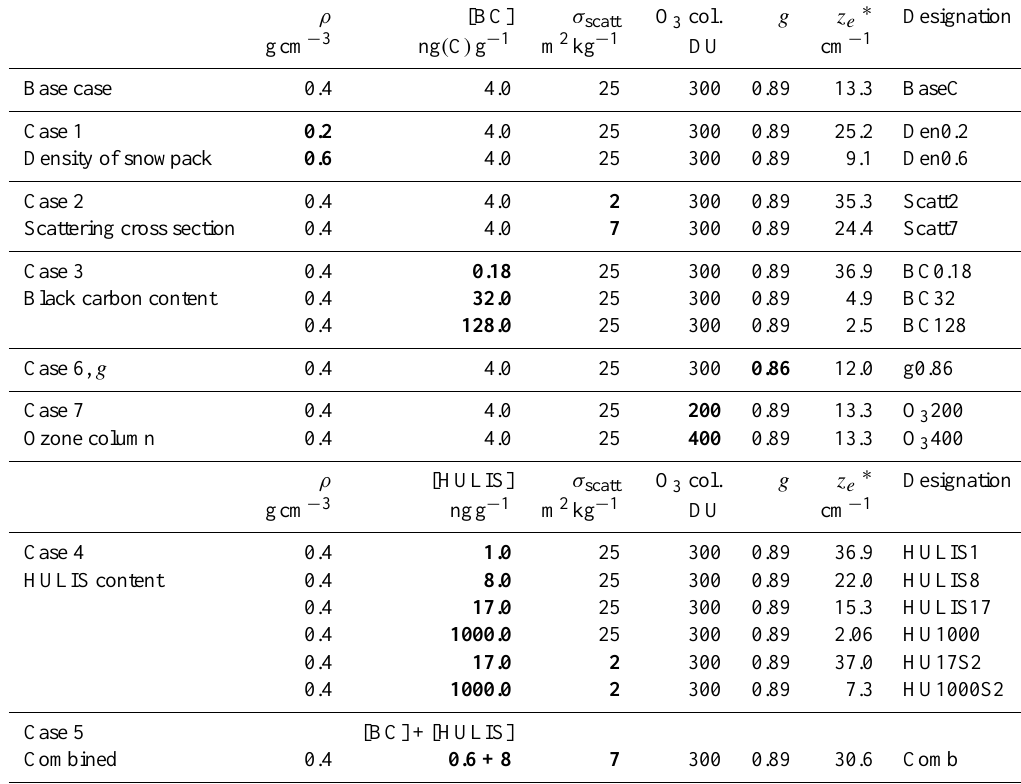
Table 3. Optical properties of the snowpacks used. The bold numbers are to highlight the optical property that is varying in that particular